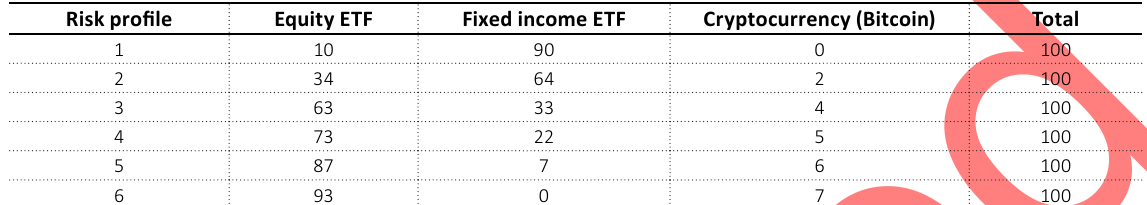
Table 7. Asset allocation for each risk profile